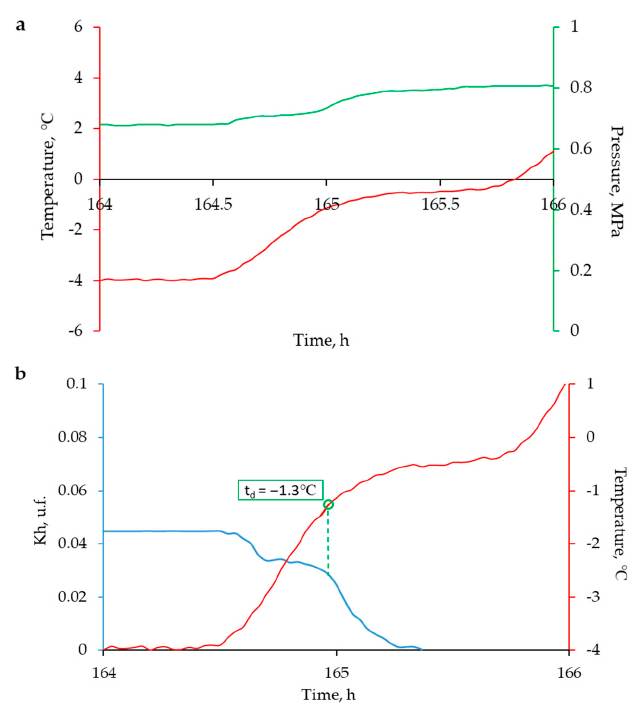
Figure 2. Time-dependent change of temperature and pressure ( a ), and hydrate coefficient ( Kh ) ( b ) in frozen hydrate-bearing sand exposed to warming. t d is the temperature corresponding to the onset of rapid pore hydrate dissociation.